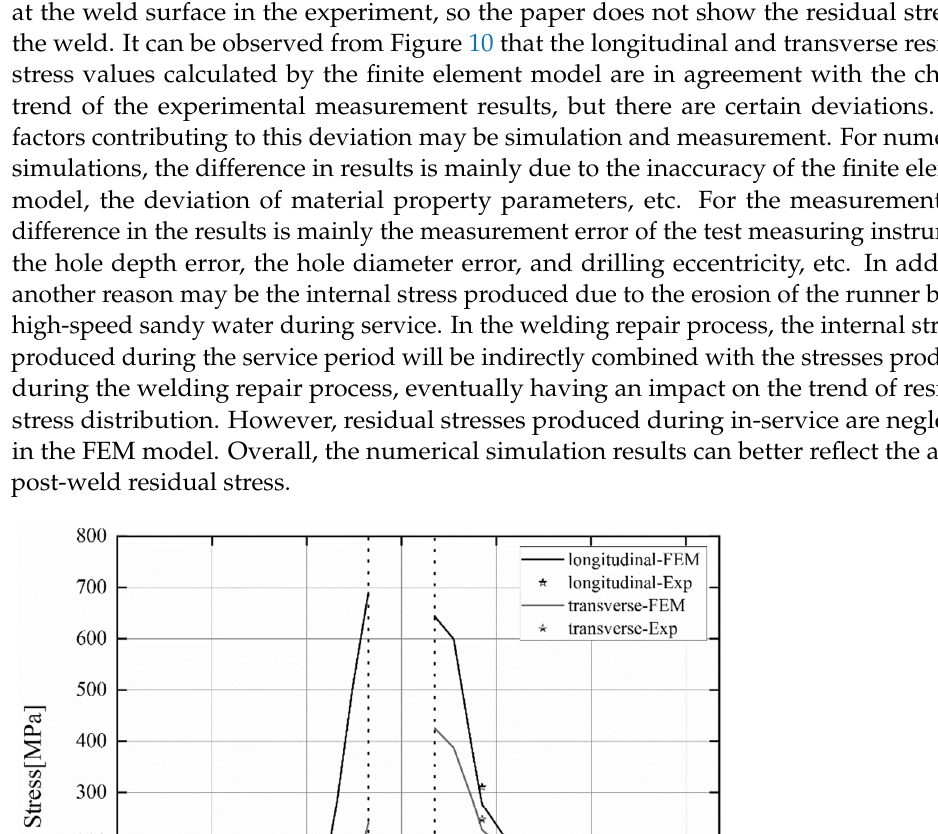
Figure 11. 3D temperature profiles on the outer surface at 94.8 s.